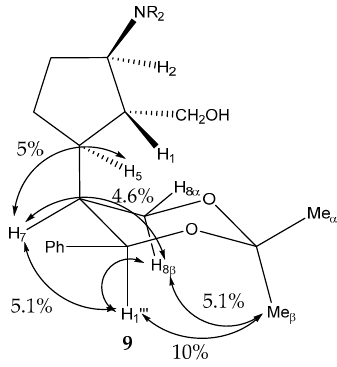
Figure 3. Significant n.O.e correlations observed for 9 .